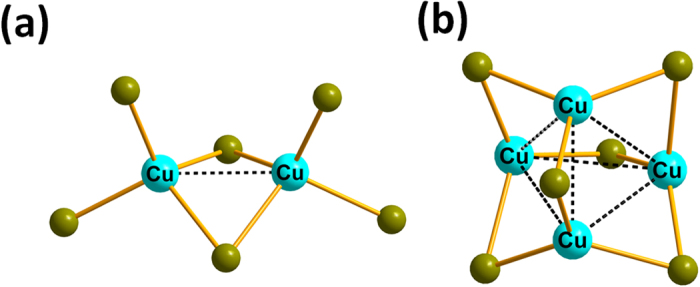
Representation of the copper bromide structures: (a) View of the copper dinuclear [Cu2Br6]4− and, (b) the copper tetranuclear [Cu4Br6]2−.